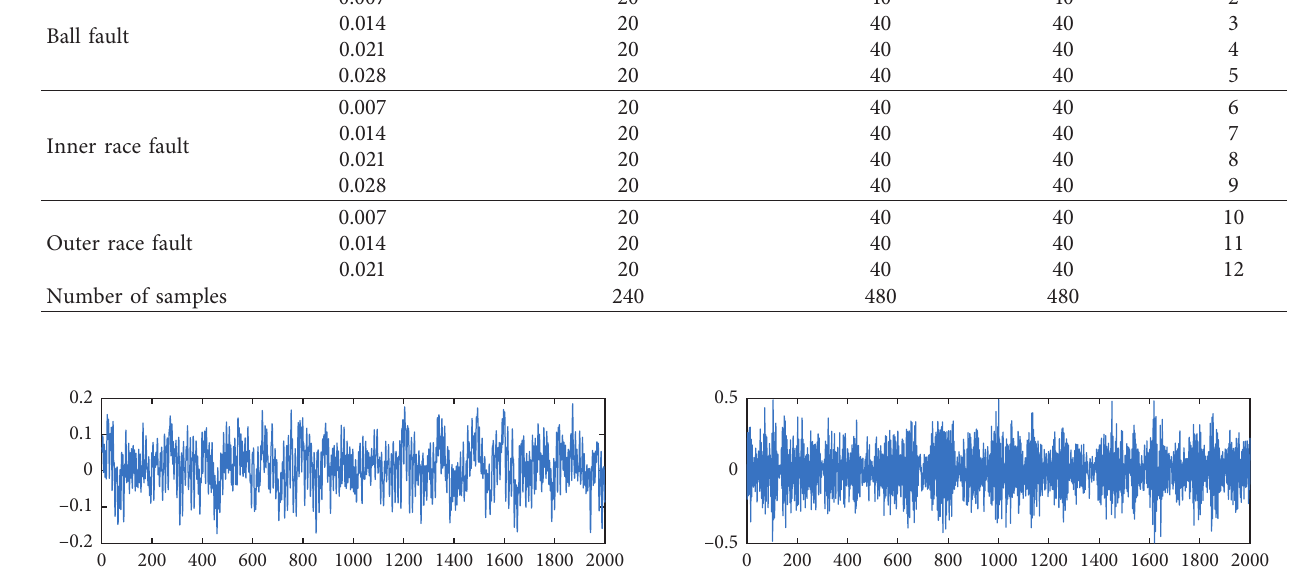
Figure 5: A normal vibration signal sample. Figure 6: A vibration signal sample of ball